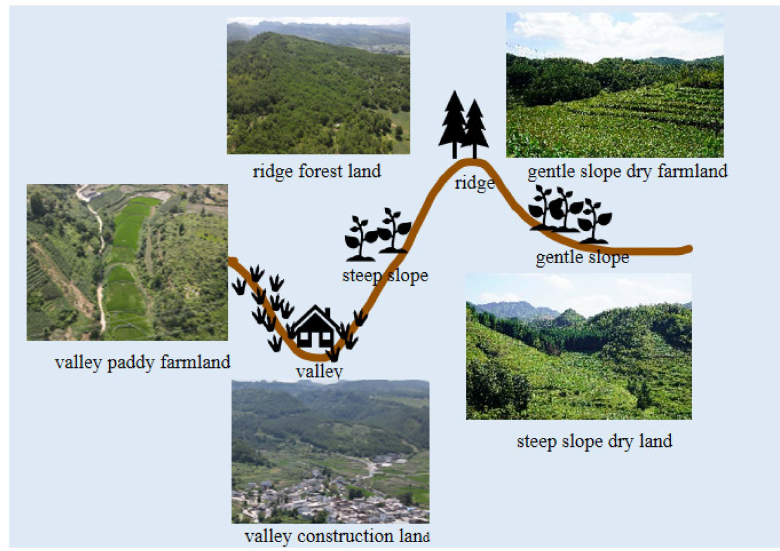
Figure 18. Different “L-SP” schematic